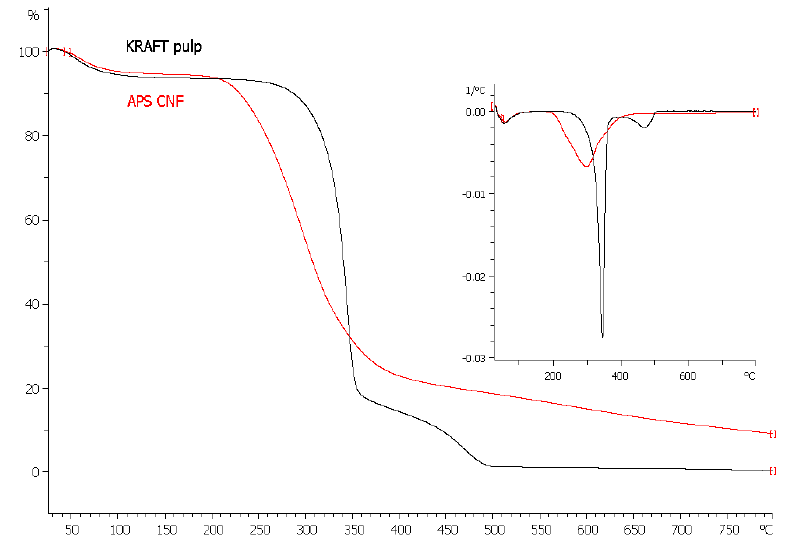
Figure 4. TG (big scale) and differential thermogravimetry DTG (small scale) curves of Kraft pulp and ammonium persulfate treated nanofibrillated cellulose (APS